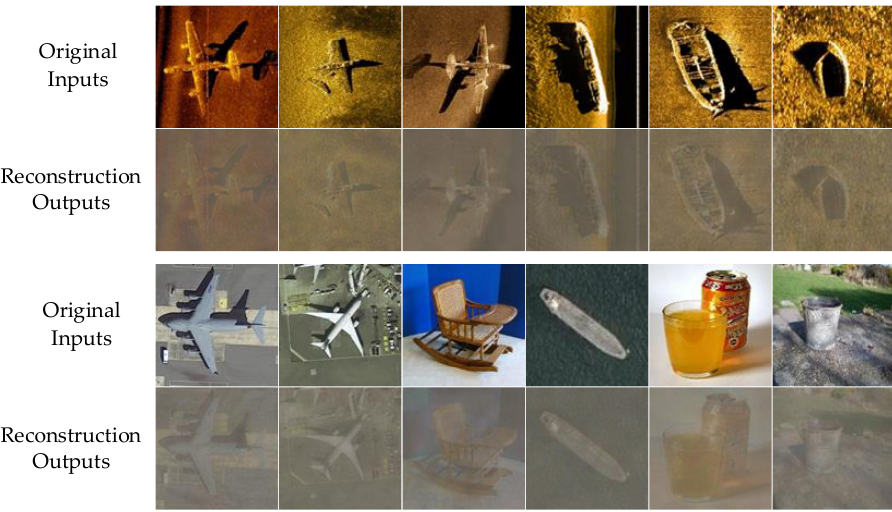
Figure 6. Results of directly decoding the whitened features on our own datasets. The upper images are the original inputs, and the bottom images are the corresponding outputs.